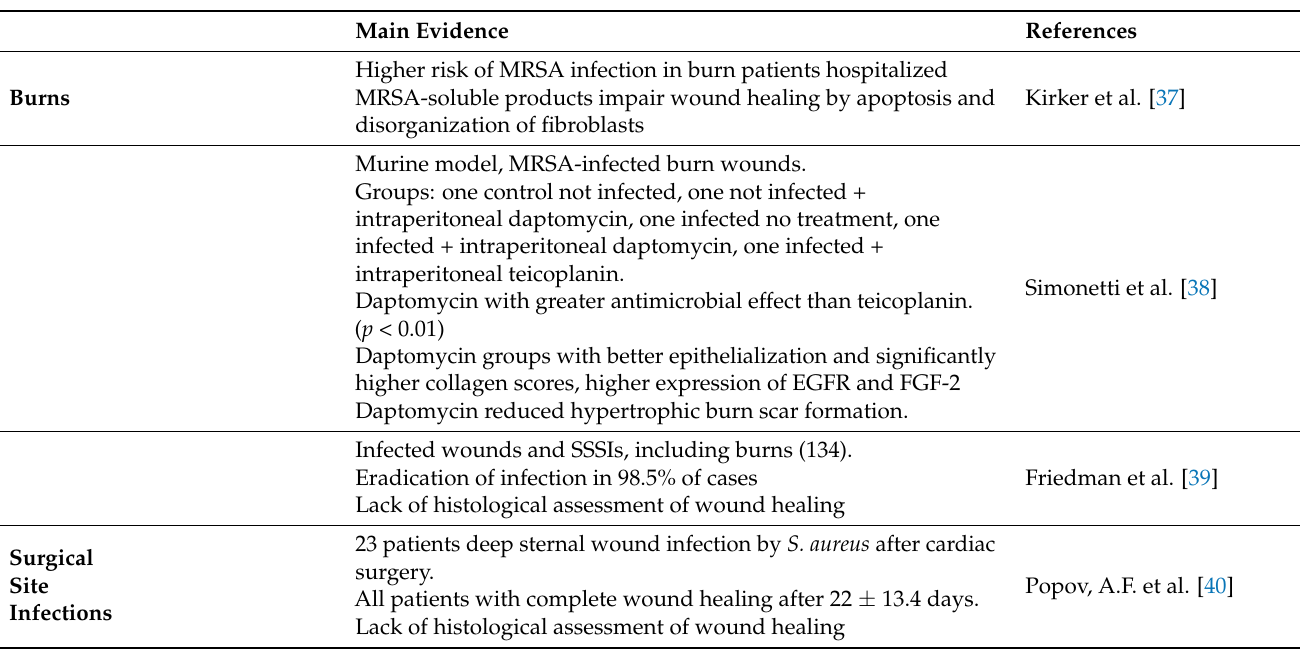
Table 1. Summary of the main evidence on the role of daptomycin in wound healing. EGFR: matrix metalloproteinase-9 TIMP-1: metallopeptidase